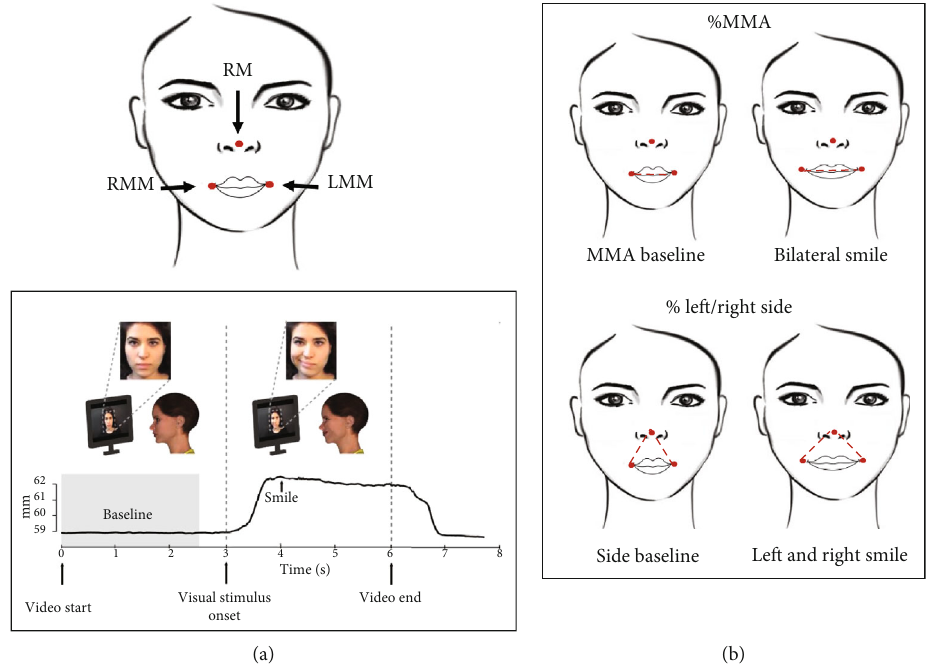
Figure 3: Kinematic parameters. (a) Example of one trial. The black line represents the excursion of the markers placed on the participant ’ s mouth. The movement began after the participants observed the actress ’ s smile and maintained the posture for about three seconds. The baseline is shown in gray. In this phase, the subject did not perform any movement. (b) Three re fl ective passive markers were placed on the participant ’ s face (left mouth marker, LMM; right mouth marker, RMM; and reference marker, RM). Bilateral smile amplitude was calculated as the maximum Euclidian distance (MMA) in millimeters between the two lip corner markers (LMM and RMM). This measure was expressed as a percentage of the MMA at baseline (%MMA). Similarly, left/right side parameters were calculated as the Euclidian distances in millimeters between LMM or RMM lip corner marker and the nose marker (RM). Left/right side parameters were expressed as the percentage of side baseline (left or right, respectively, before movement Table 1: Patient classi fi cation: demographics and clinical characteristics of patients.